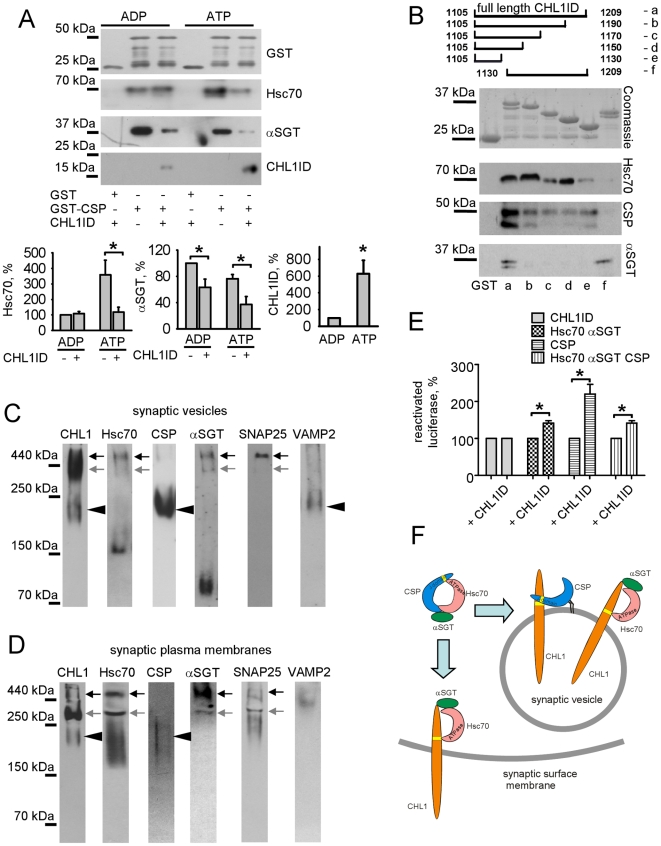
CHL1 recruits Hsc70 and αSGT to synaptic vesicles but inhibits their association with CSP by forming dimeric CHL1/CSP and trimeric CHL1/Hsc70/αSGT complexes.
A - GST and GST-tagged CSP immobilized on beads were assayed for their ability to pull down Hsc70 and αSGT from a mixture of these proteins in the presence of ADP or ATP with or without CHL1ID. Graphs show mean optical density of the blots ± SEM (n = 6). For quantitation of the binding of Hsc70 and αSGT to CSP (graphs on the left and in the middle, respectively), levels of these proteins bound to CSP in the presence of ADP and absence of CHL1ID were set to 100%. For quantitation of the binding of CHL1ID to CSP (graph on the right), levels of CHL1ID bound to CSP in the presence of ADP were set to 100%. Note that in the presence of ATP, CHL1ID binds to CSP with higher efficiency than in the presence of ADP. CHL1ID inhibits αSGT/CSP complex formation in a nucleotide independent manner and inhibits ATP-dependent formation of the Hsc70/CSP complex. *p<0.05, paired t-test (compared as indicated). B - Scheme (top) shows CHL1ID fragments marked alphabetically that were immobilized on beads via the GST tag and assessed for their ability to pull down Hsc70, CSP or αSGT. Coomassie blue stained gel shows that similar levels of CHL1 fragments were immobilized on beads. Lower molecular weight degradation products of the recombinant proteins are also observed. Binding of Hsc70, CSP and αSGT to CHL1ID fragments was analyzed by Western blot with the corresponding antibodies. Note that amino acids 1105–1130 within CHL1ID are necessary to bind Hsc70 and CSP, while amino acids 1190–1209 are necessary to bind αSGT. Double bands recognized by CSP antibodies represent oligomeric forms of recombinant CSP as described previously [51]. C,D - Molecular complexes in synaptic vesicles (C) and synaptic plasma membranes (D) were separated by PAGE under non-denaturing conditions and probed by Western blot with the indicated antibodies. Two or more proteins were considered in a presumed complex, if their bands in the gel overlapped at the apparent molecular weight calculated to be equal or above the total molecular weight of the sum of the weights of the proteins together. In accordance with this criterion, arrows show overlapping bands of CHL1, Hsc70, and αSGT that presumably represent the CHL1/Hsc70/αSGT complex. Note that CHL1/Hc70/αSGT complex migrates at the two levels in the native gel probably due to the multimerization of its components or presence of additional binding partners in the slower migrating level (black arrows) compared to faster migrating level (grey arrows). The higher molecular weight level is more evident in synaptic vesicles, while lower molecular weight level is more evident in synaptic plasma membranes. Arrowheads show overlapping bands of CHL1 and CSP that presumably represent the CHL1/CSP complex. Only complexes of CHL1 together with Hsc70, CSP or αSGT are marked. Note that trimeric Hsc70/CSP/αSGT complexes are not detectable in the gels since CSP bands do not overlap with αSGT bands. In D, a CHL1 band overlapping with Hsc70 and CSP immumoreactive bands at ∼230 kDa may contain only the CHL1/CSP complex of ∼230 kDa but not CHL1/Hsc70/CSP or CHL1/Hsc70 complexes with molecular weights above 250 kDa. Note SNAP25 and VAMP2 positive bands, which overlap with CHL1/Hsc70/αSGT and CHL1/CSP complexes, respectively. In synaptic plasma membranes, VAMP2 accumulates in a high molecular weight complex with a slightly different molecular weight than that of the CHL1/Hsc70/αSGT complex. E - Graphs show mean levels of activity ± SEM (n = 6) of luciferase reactivated by indicated combinations of chaperones. Values were normalized to luciferase reactivation levels in the absence of the added CHL1ID set to 100%. *p<0.05, paired t-test. F - Schematic model diagram of CHL1-containing chaperone complexes. The Hsc70/CSP/αSGT complex dissociates into the CHL1/CSP complex present in synaptic vesicles and the CHL1/Hsc70/αSGT complex present in synaptic vesicles and plasma membranes. HPD tripeptides within the intracellular domain of CHL1 and the J-domain of CSP are marked in yellow.